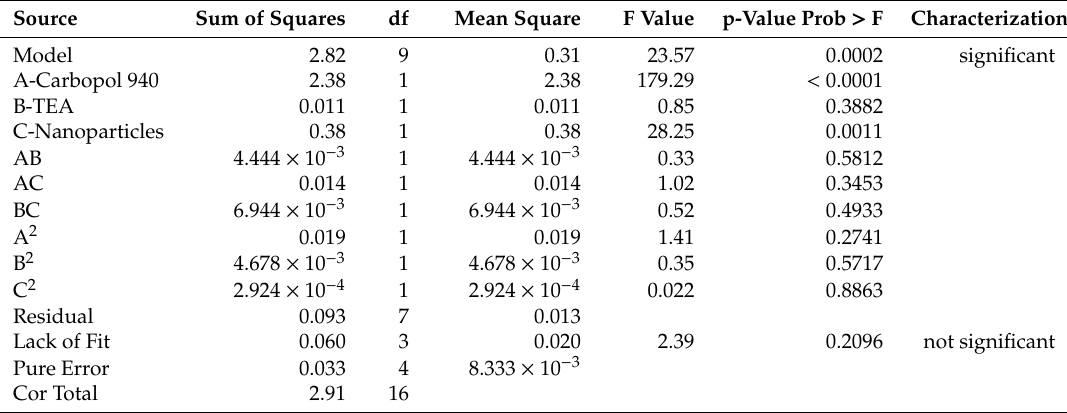
Table 5. ANOVA analysis for the quadratic model of the spreadability of the arabica co ff ee ground nanoparticles gel